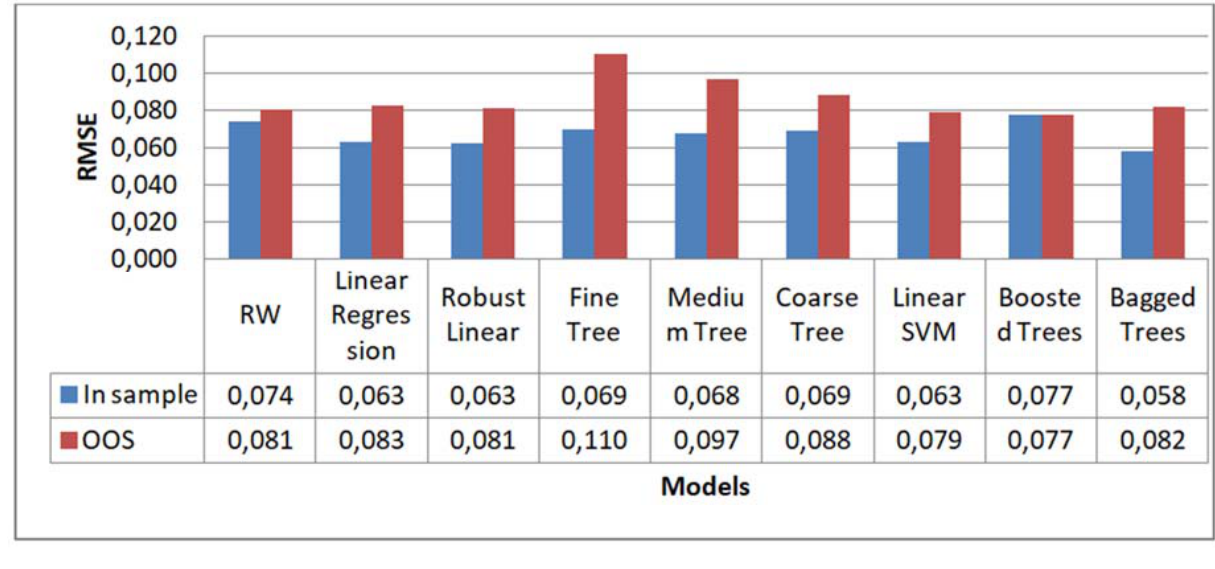
Figure 7. RMSE for t + 3 forecasting.